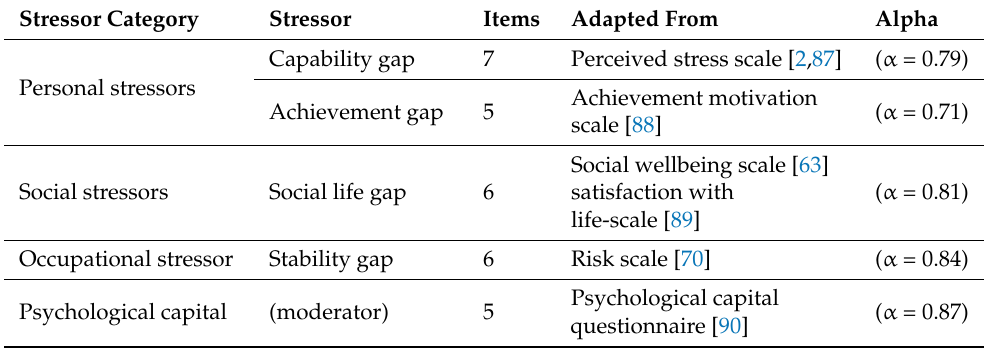
Table 1. Measures and